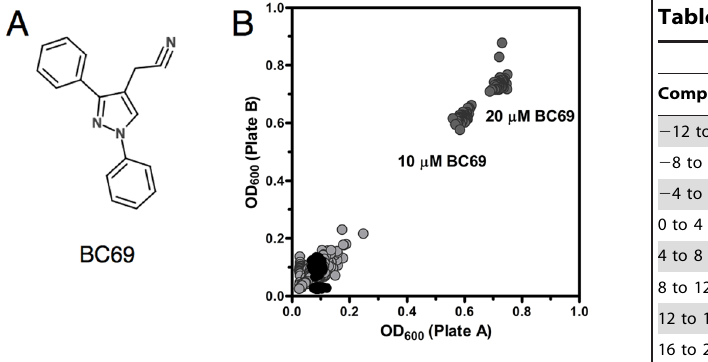
Figure 1. Development of a PDE8A inhibitor HTS. A) Structure of PDE4/8 inhibitor BC69 used to optimize PDE8 inhibitor assay. B) A yeast-based screen finds no potent PDE8 inhibitors in a Known Bioactives Collection. PDE8A-expressing strain CHP1204 was screened against 2,640 known bioactive compounds in duplicate wells (plate A and B). Scatter plot of absorbance values from plate A against plate B is shown. Negative control wells contained 0.2% DMSO (black circles), positive control wells contained 10 or 20 m M BC69 (dark gray circles). Experimental wells are shown in light gray. The data set has a correlation value of 0.996.